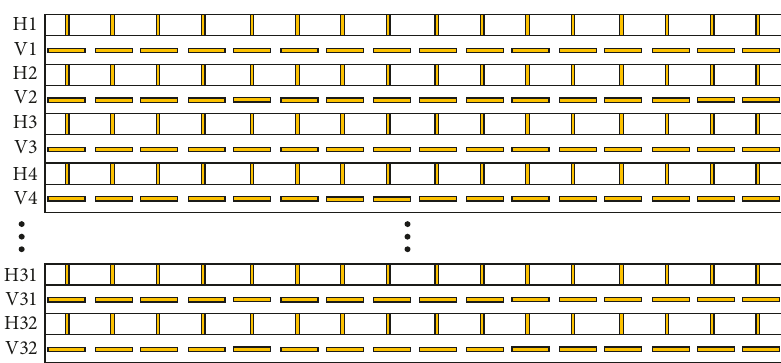
Figure 4: The diagram of the waveguide slot antenna in the elevation direction.